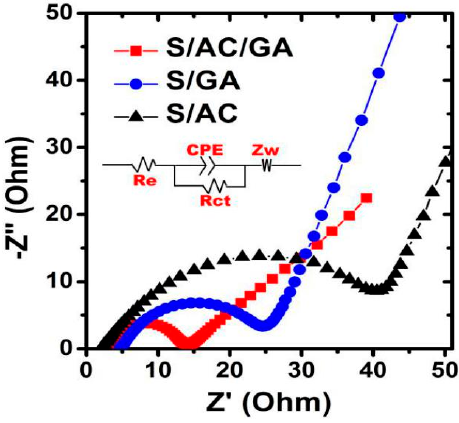
Figure 11. Electrochemical impedance spectroscopy (EIS) impedance spectra of S/AC, S/GA, and S/AC/GA cathodes. Table 1. Equivalent circuit parameters obtained from fitting the impedance spectra.